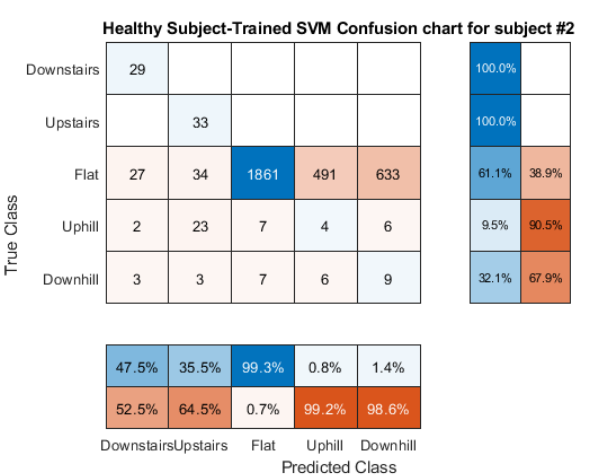
Figure A7. Support Vector Machine Confusion Chart for ILLA participant A1 as trained by healthy in- dividuals.